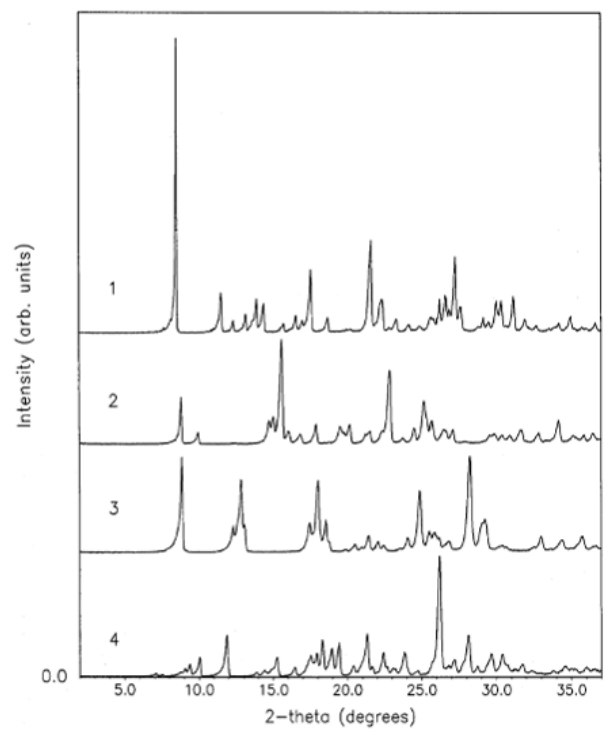
Figure 8. PXRD patterns of piroxicam form I (1), form II (2), form III (3) and the monohydrate (4) (reprinted from [55], Copyright 2003, with permission from